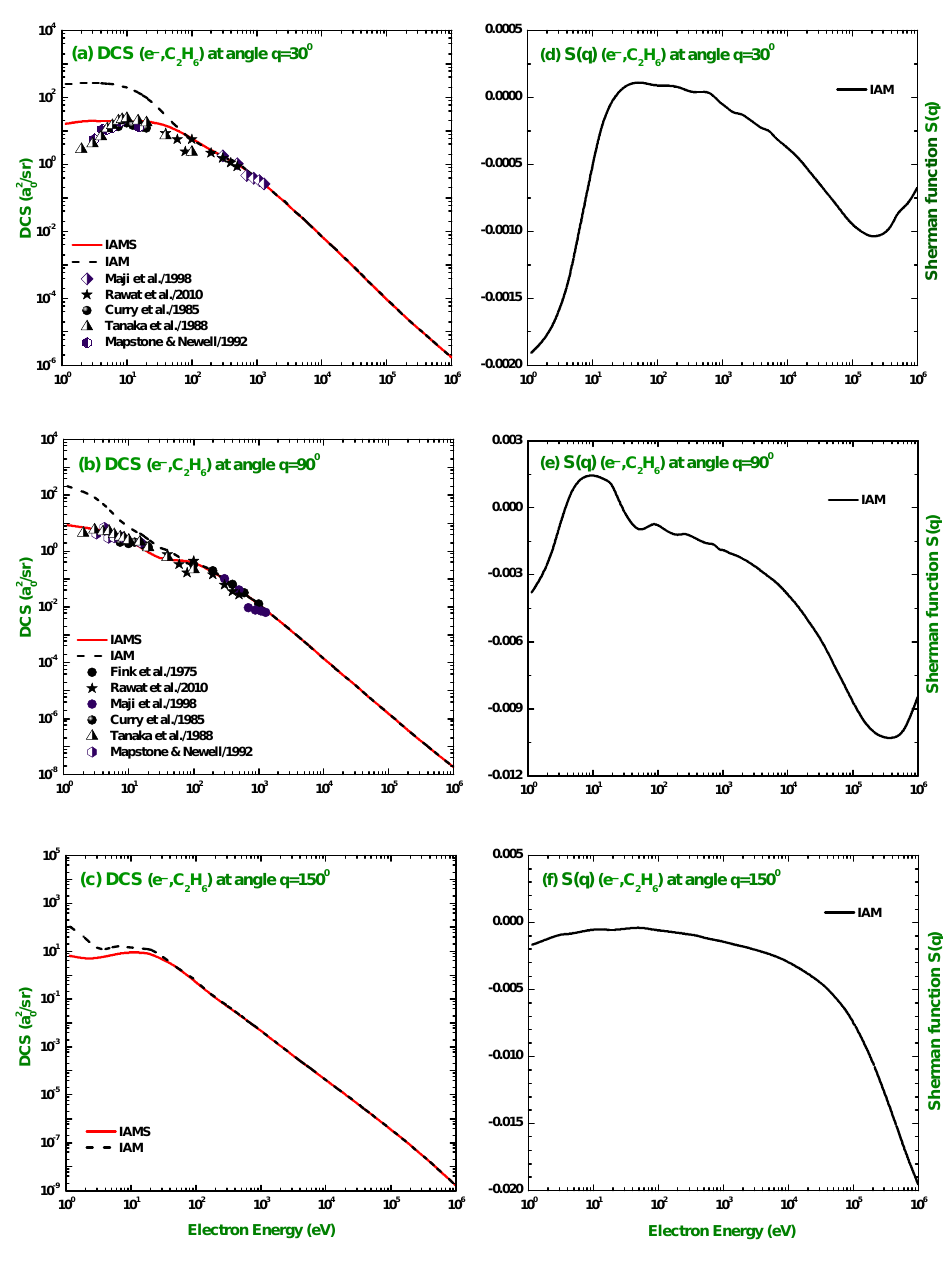
Figure 10. Energy dependence of DCS ( a 2 / sr ) and the Sherman function for the elastic scattering of 0 electrons from C 2 H 6 at angles 30 ◦ , 90 ◦ , and 150 ◦ . Theoretical works: IAM and IAMS; Experimental works: Maji et al. [27], Rawat et al. [23], Curry et al. [20], Mapstone and Newell [24], Tanaka et al. [22], and Fink et al.